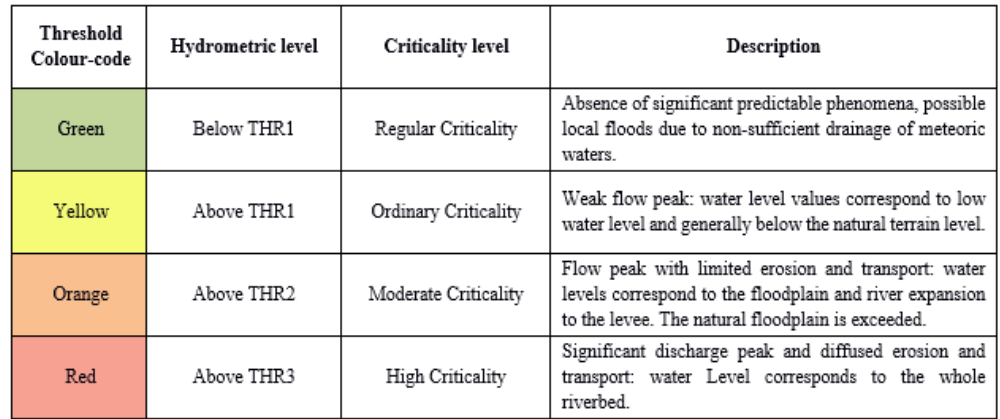
Table 1. Hydrogeological criticality levels officially defined by the Civil Protection authorities. Regional functional centres define hydromet- ric thresholds, in relevant river sections. Those thresholds are based on the return period concept, in order to individuate the criticality level to be assigned to the whole warning area (definitions conform to Deliberation no. 659/2017 of the Abruzzo Regional Council,